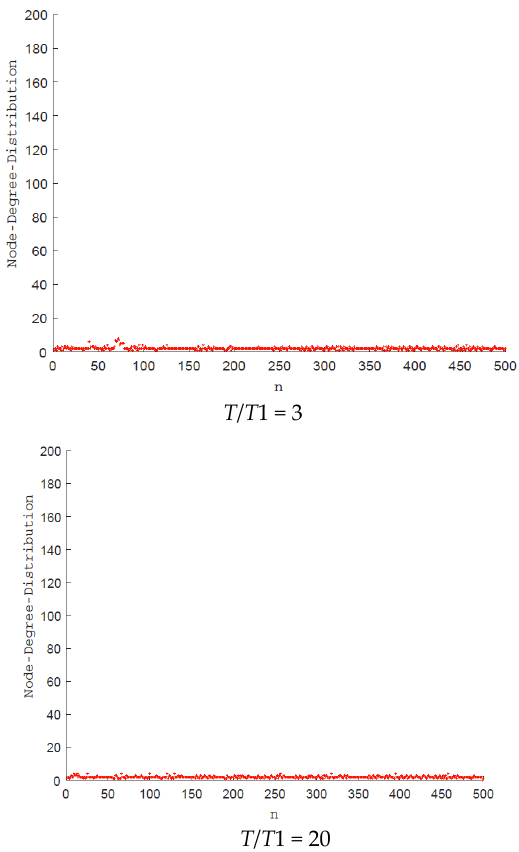
Figure 5. Evolution of node degree distribution with time .